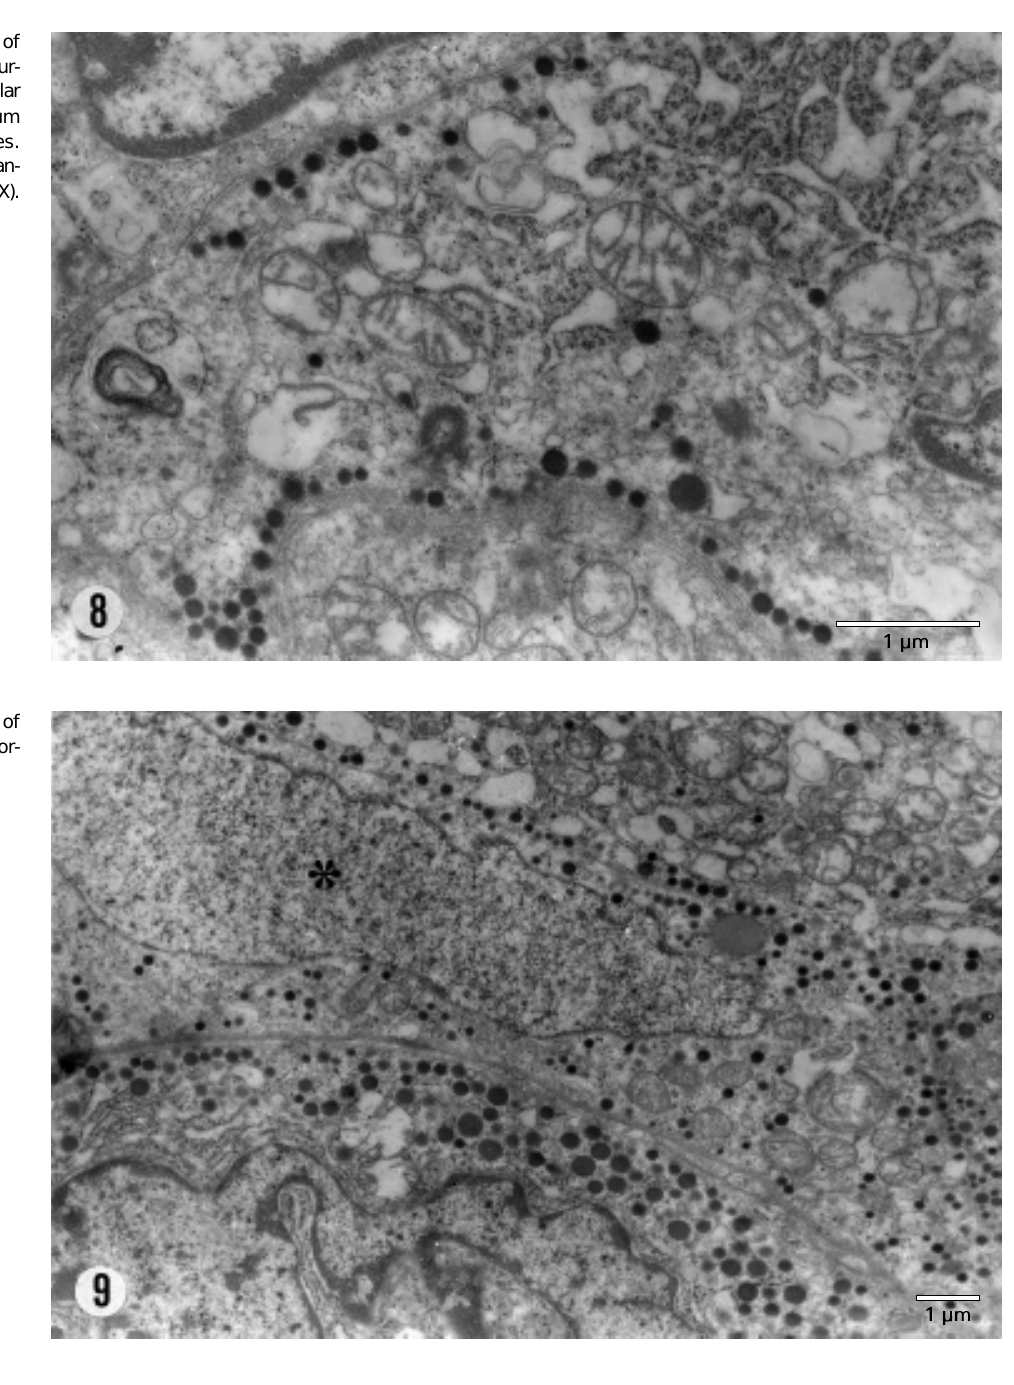
Figure 8 - Electron micrograph of a TSH cell from an undernour- ished animal showing irregular rough endoplasmic reticulum with abundant polyribosomes. Small peripheral secretory gran- ules are also observed (24,000X).